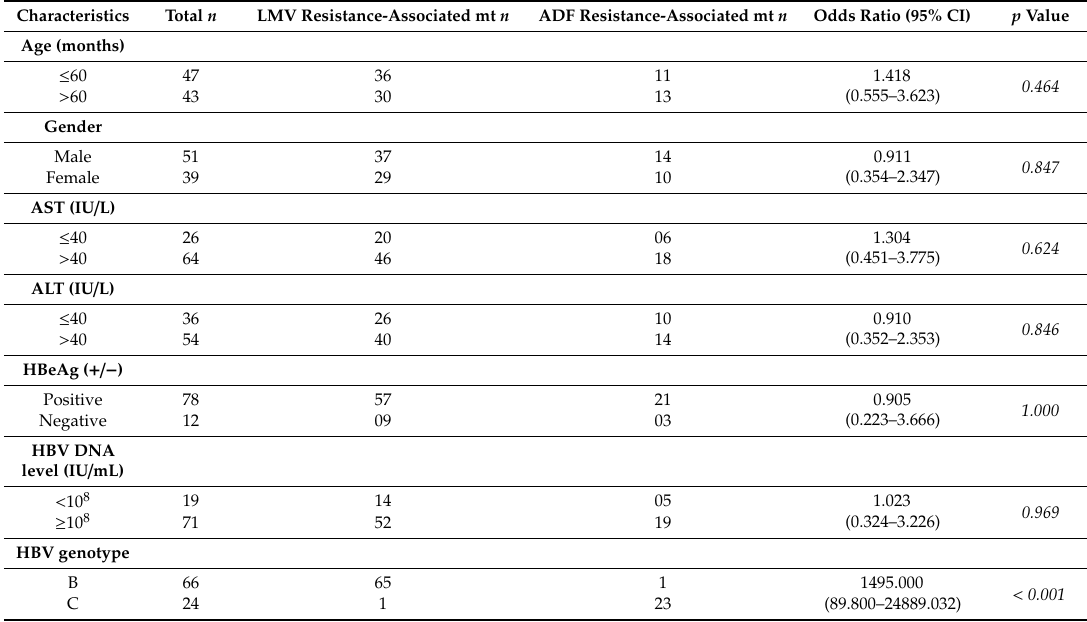
Table 2. Association of Lamivudine (LMV) and Adefovir dipivoxil (ADF) resistance mutations with patients characteristics.